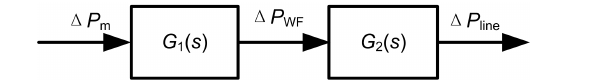
Figure 4. Block diagram of the series interconnection of the two